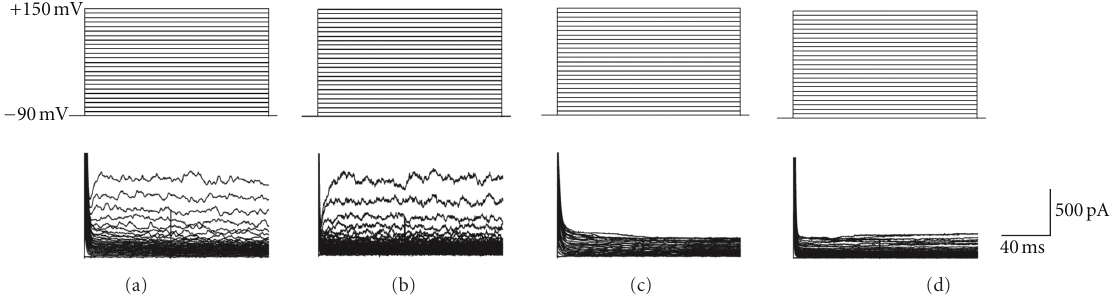
Figure 1: Representative whole cell patch clamp recordings showing outward currents elicited by step depolarization from − 90 mV to 150mV with 5 mV increments and holding for 200 ms. Bovine articular chondrocytes were treated with PBS (a), 7.5 mg/mL hyaluronan (b), 0.25% bupivacaine (c), and a mixture of 7.5mg/mL hyaluronan and 0.25% bupivacaine (d).